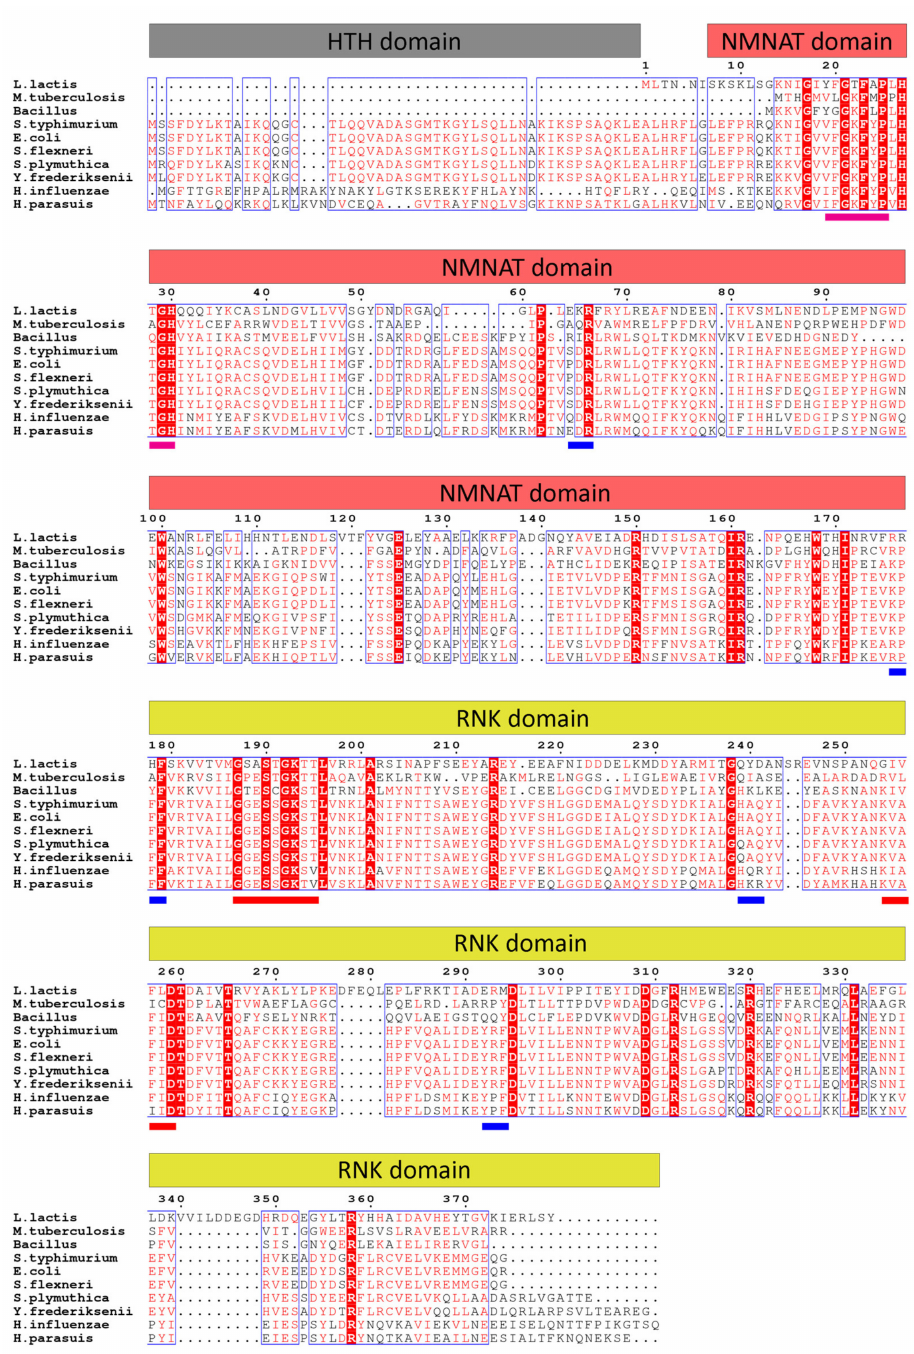
Figure 1. Multiple sequence alignment of NadR proteins from selected organisms. The amino acid residues are colored based on conservation, amino acids colored red are similar in more than 50% of the aligned NadR sequences. The amino acid residues in the red columns are conserved in all aligned NadR sequences. Organisms’ names: L. lactis ( Lactococcus lactis ), M. tuberculosis ( Mycobacterium tuberculosis ), Bacillus sp. ( Bacillus sp. ), S. typhimurium ( Salmonella typhimurium ), E. coli ( Escherichia coli ), S. flexneri ( Shigella flexneri ), S. plymutica ( Serretia plymutica ), Y. frederiksenii ( Yersenia frederiksenii ), H. influenzae ( Haemophilus influenzae ), and H. parassuis ( Haemophilus parassuis ). The bars on top show the locations of the three distinct domains of NadR proteins. The blue bars below the alignment indicate NAD binding residues, the red bars walker A and walker B motifs, and the pink bars are the phosphate-binding